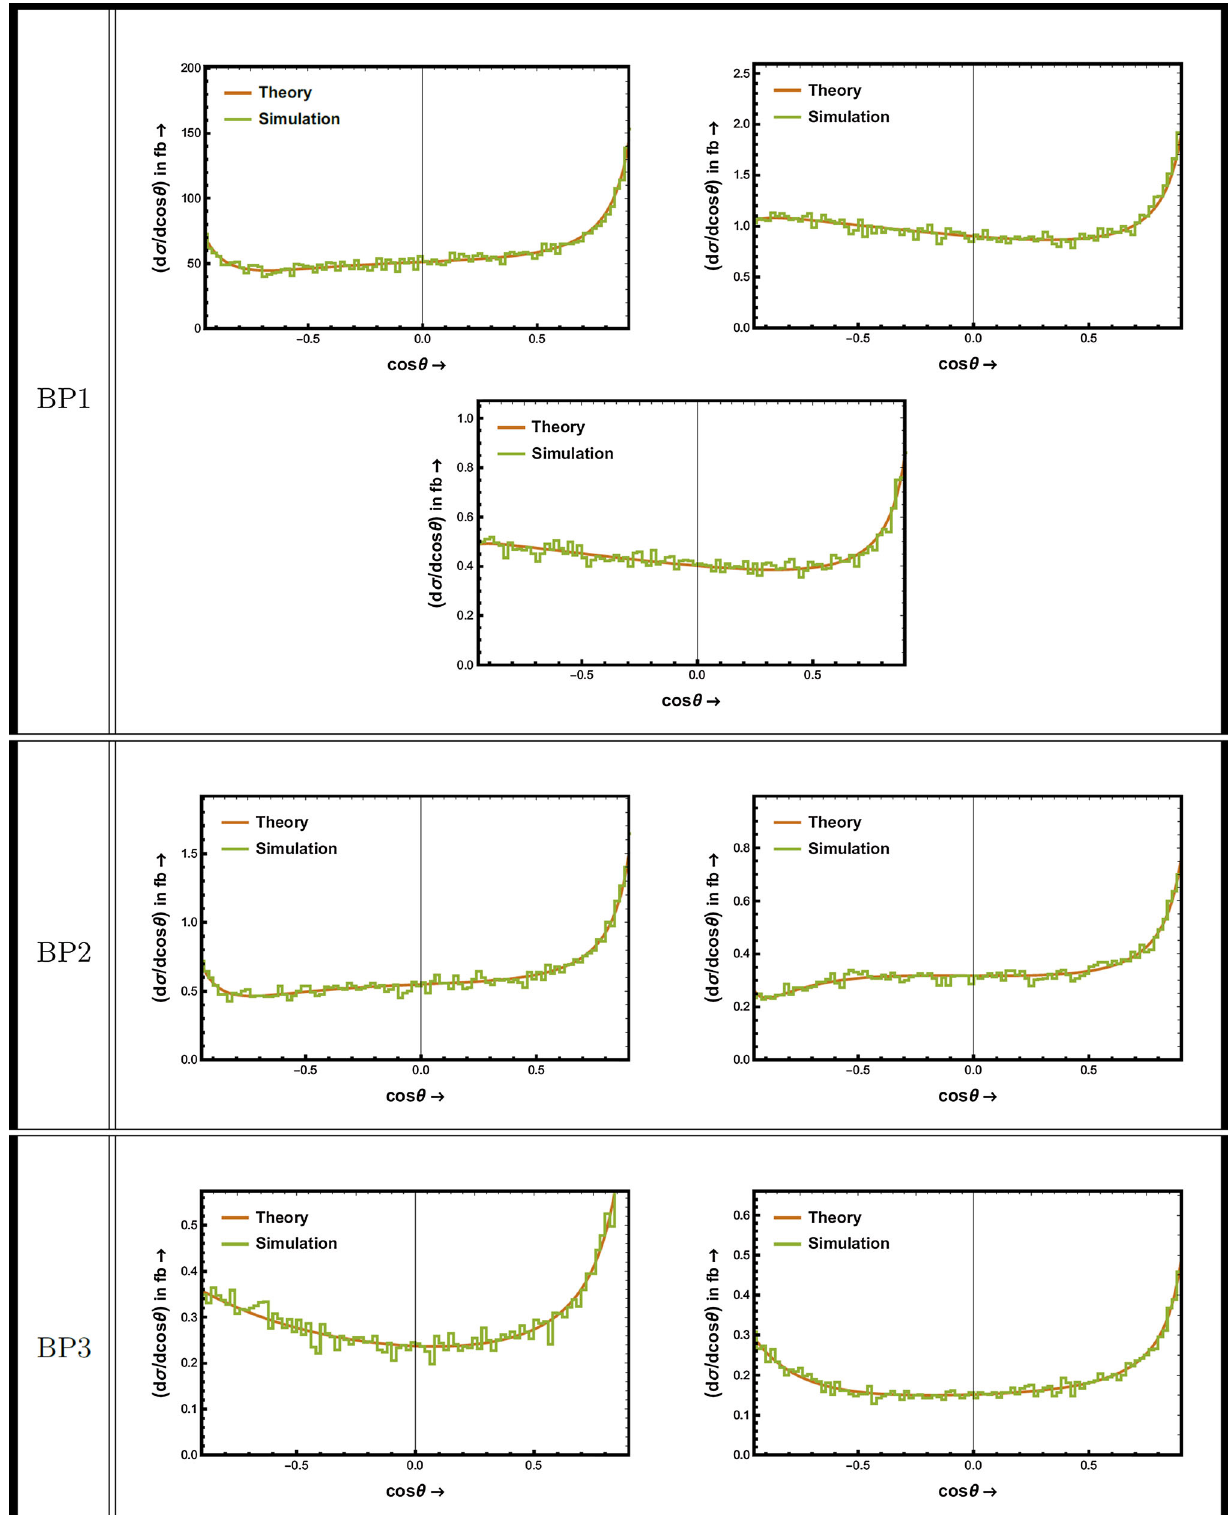
/ 3 ) c at various ical expectations whereas the green (jagged) lines signify the PYTHIA 3 simulated